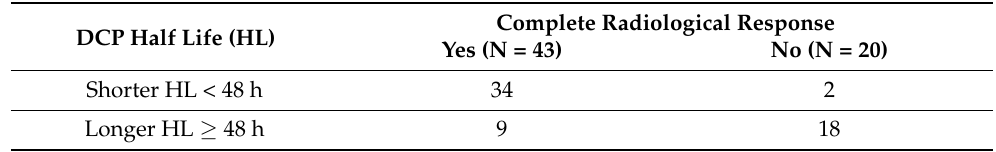
Table 2. Difference in DCP half-life between complete and incomplete response RFA patients by standard image modality.